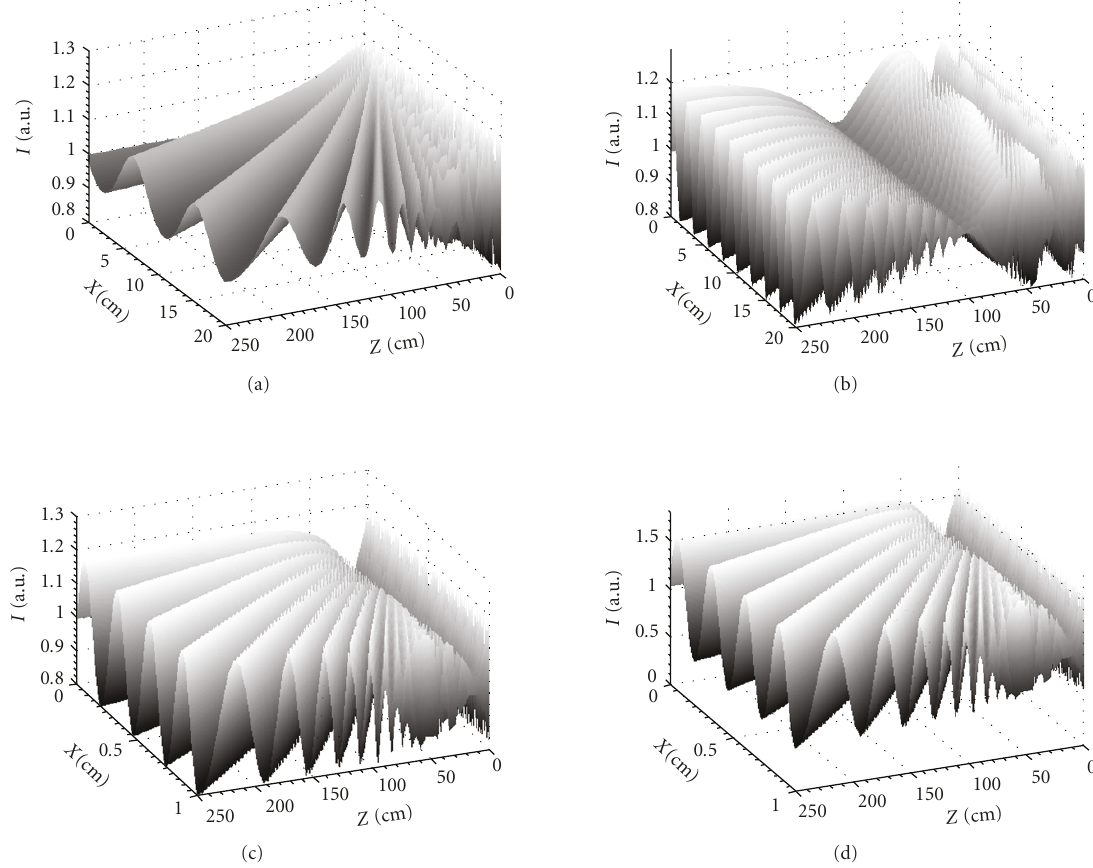
Figure 4: The intensity distribution of the light transmitted by a sinusoidal phase grating with L = 0 . 025cm in the Fresnel zone for a spherical wave illumination: (a) m = 0 . 1, s = 7cm; (b) m = 0 . 1, s = 30cm; (c) m = 0 . 1, s = 12cm; (d) m = 0 . 3, s = 12cm.